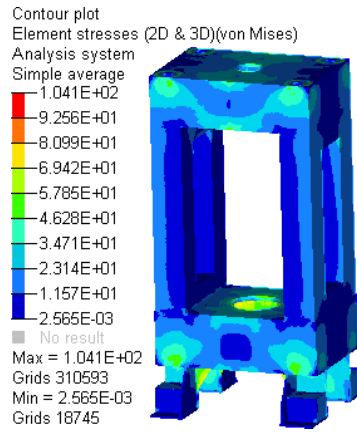
Figure 8. Effective stress.